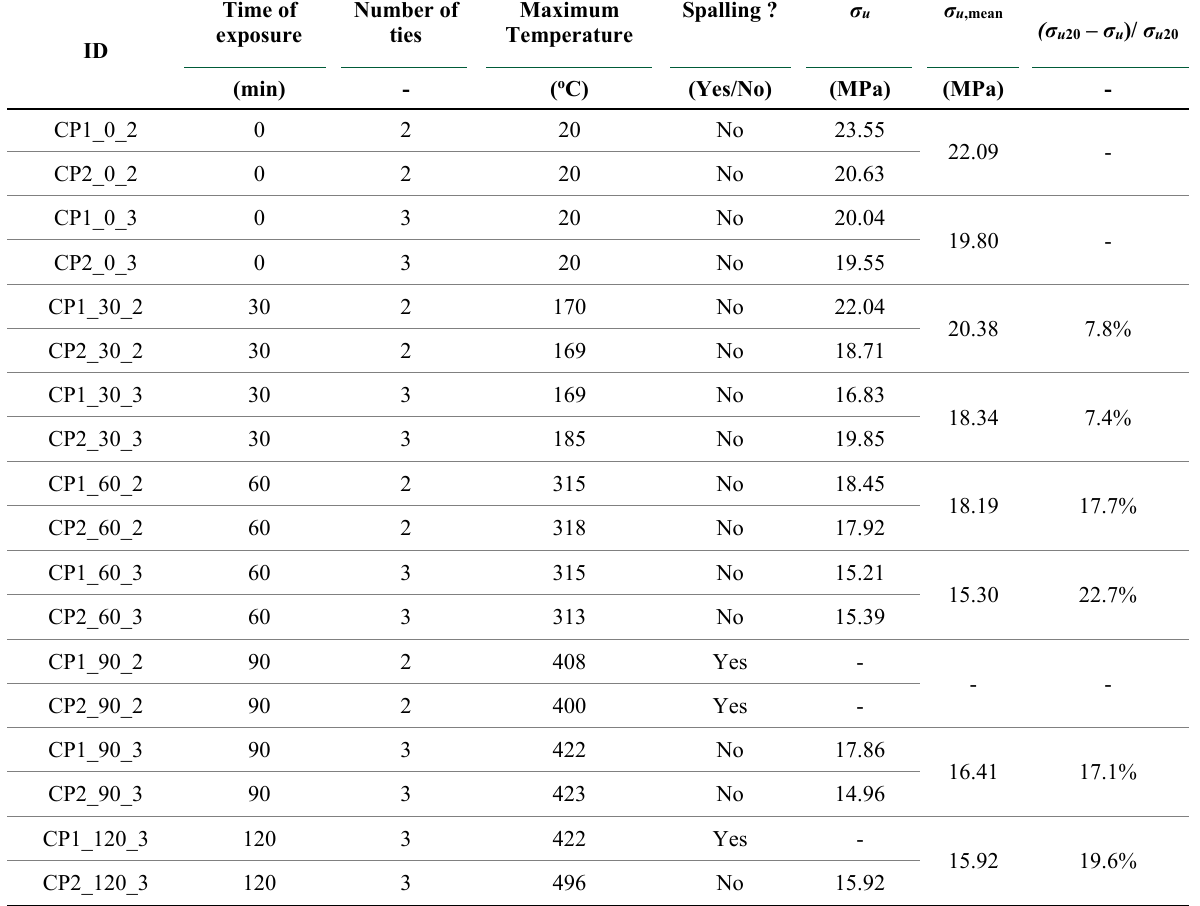
Table 2. Identification (ID) of stub columns of Stage II and summary of results.